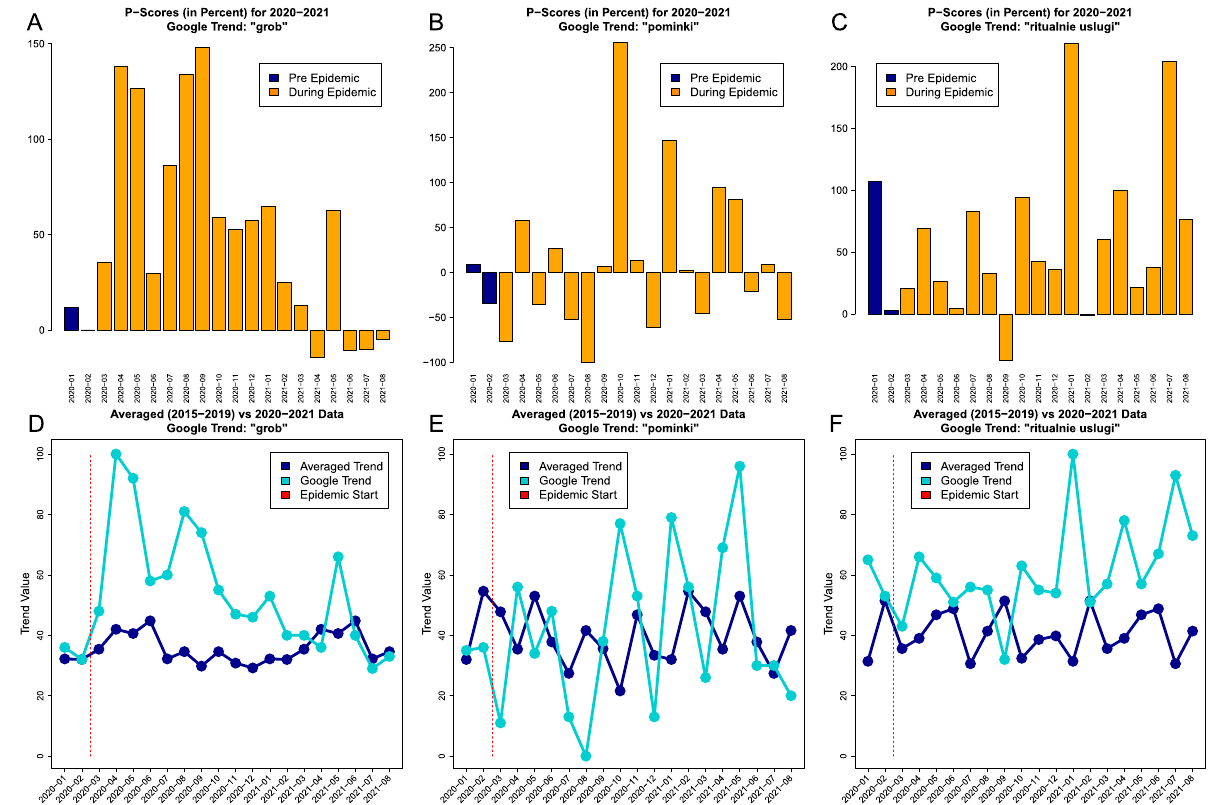
Figure 4. The visual summaries of non-parametric Google Trends searches P -scores are presented for coffin (panel A ), memorial service (panel B ) and funeral services (panel C ) where orange bars are used for the epidemic period. The corresponding averaged data based on five years (dark blue) are plotted together with the queries data (cyan) for coffin (panel D ), memorial service (panel E ) and funeral services (panel F ). Vertical red bars indicate the epidemic start